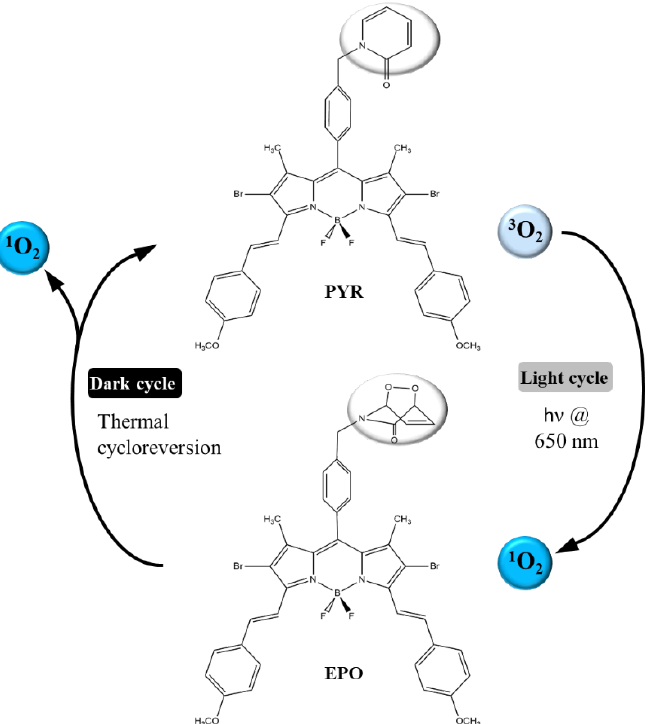
Figure 4. Schematic illustration of the mechanism of the novel fractional PDT photosensitizer (PS) based on the 2-pydidone-conjugated boron–dipyrromethene (BODIPY). Reproduced with permis- sion [92]. Copyright 2016, Wiley-VCH.